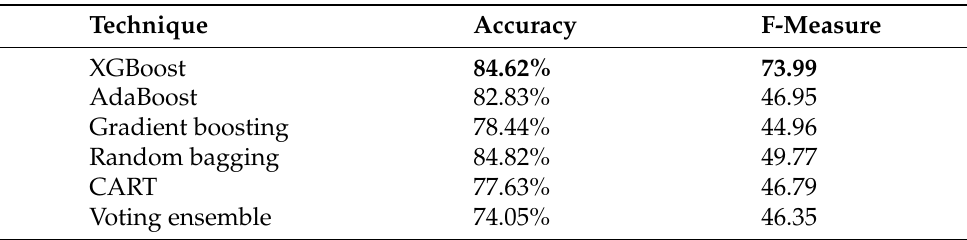
Table 4. The performance of the proposed system with XGBoost, and compared to other decision tree (DT) ensemble algorithms.